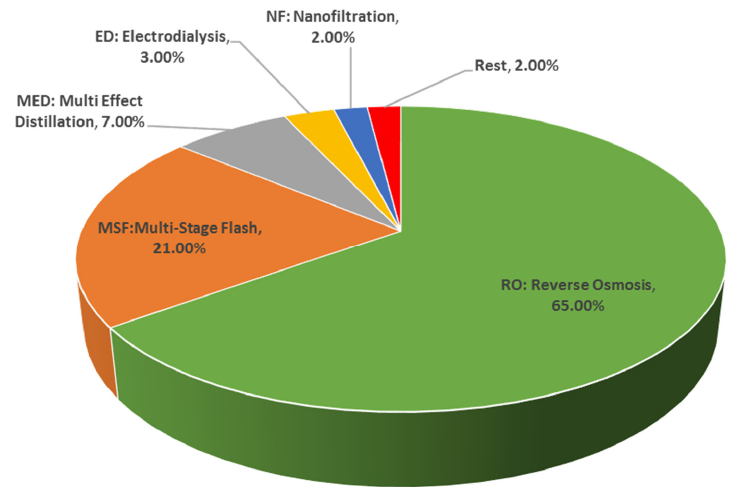
Figure 2. The shares of desalination methods in installed capacity. Reprinted figure with permission from [17]. Copyright (2018) Elsevier.